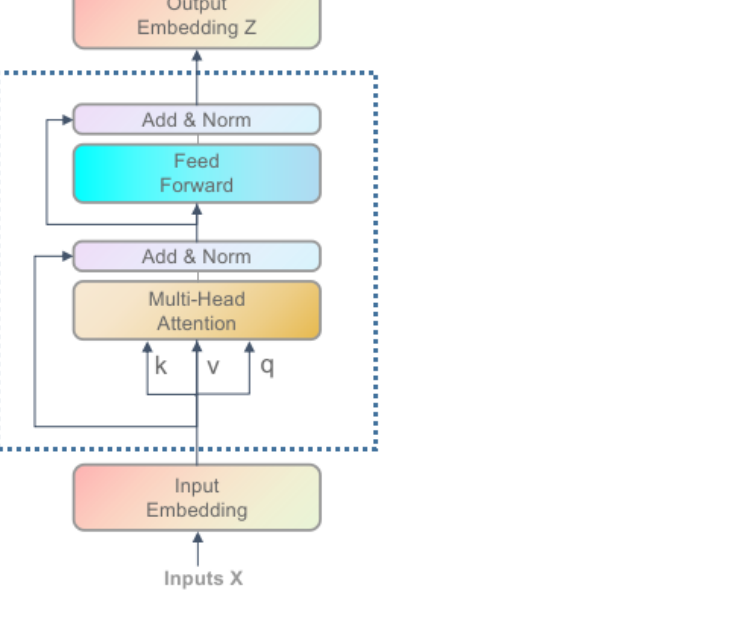
Figure 5. Architecture of our Multi-head